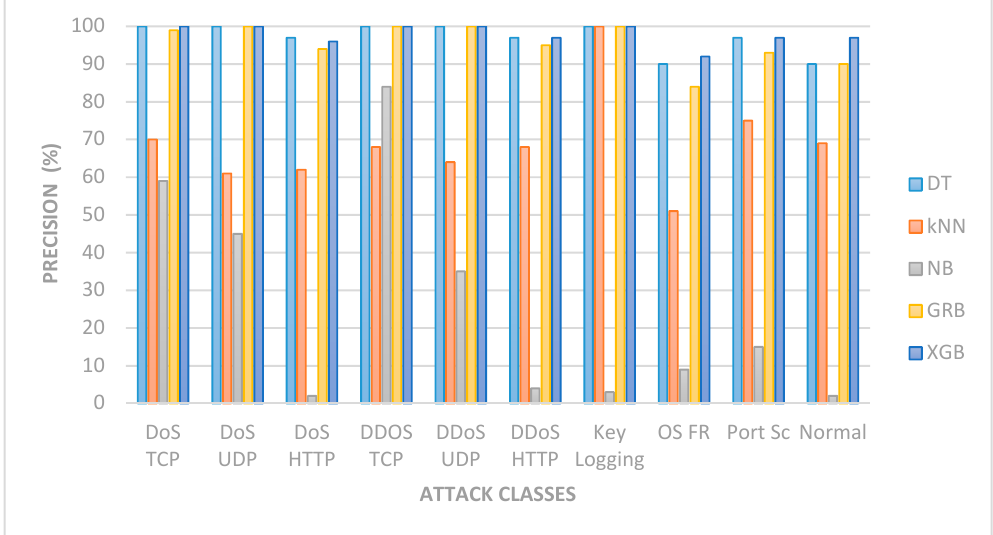
Figure 11. Precision of multiclass classification Instances.